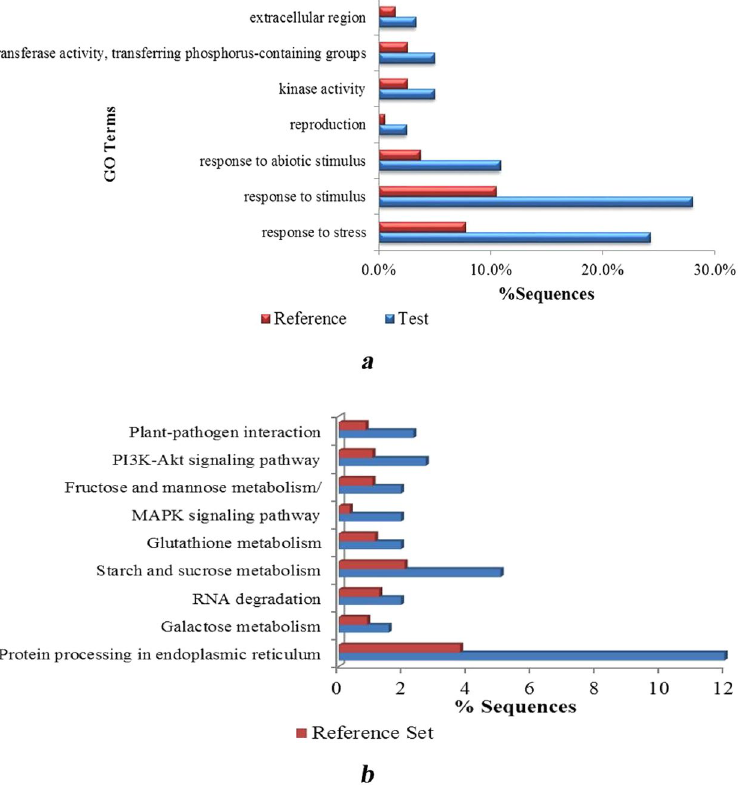
Figure 2. GO enrichment analysis and KEGG pathway enrichment analysis of differentially expressed proteins. ( a ) Significantly enriched GO terms in the differentially expressed proteins of wheat cultivar Jing411. ( b ) KEGG pathway enrichment analysis for differentially expressed proteins in wheat cultivar